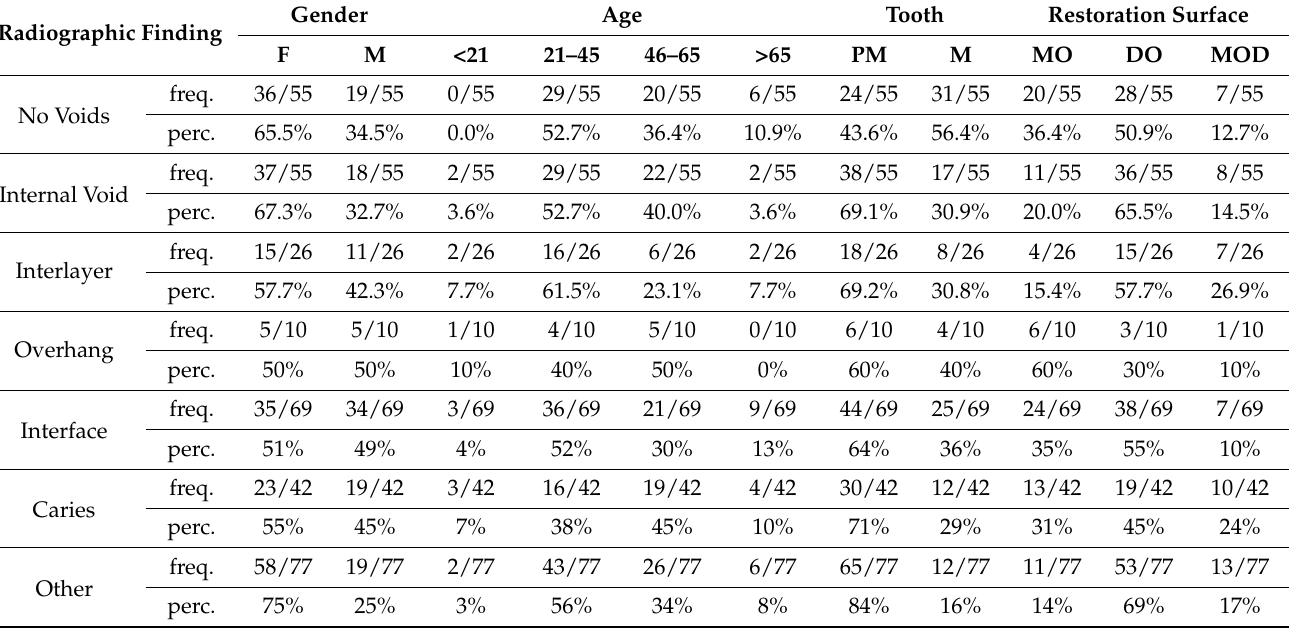
Table 3. The prevalence of radiographic abnormalities found in class II composites restorations among genders, age groups, tooth, and restoration